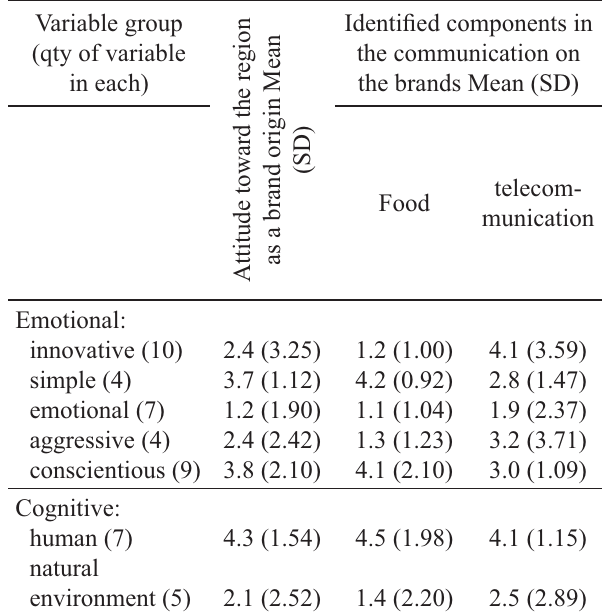
Table 2. Descriptive analysis of